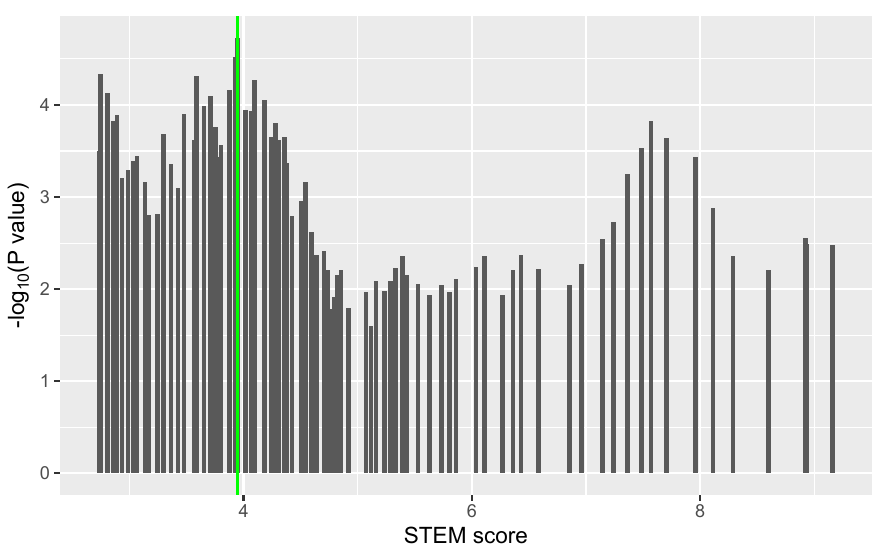
Figure 11. An illustration of optimal cutoff identification for STEM